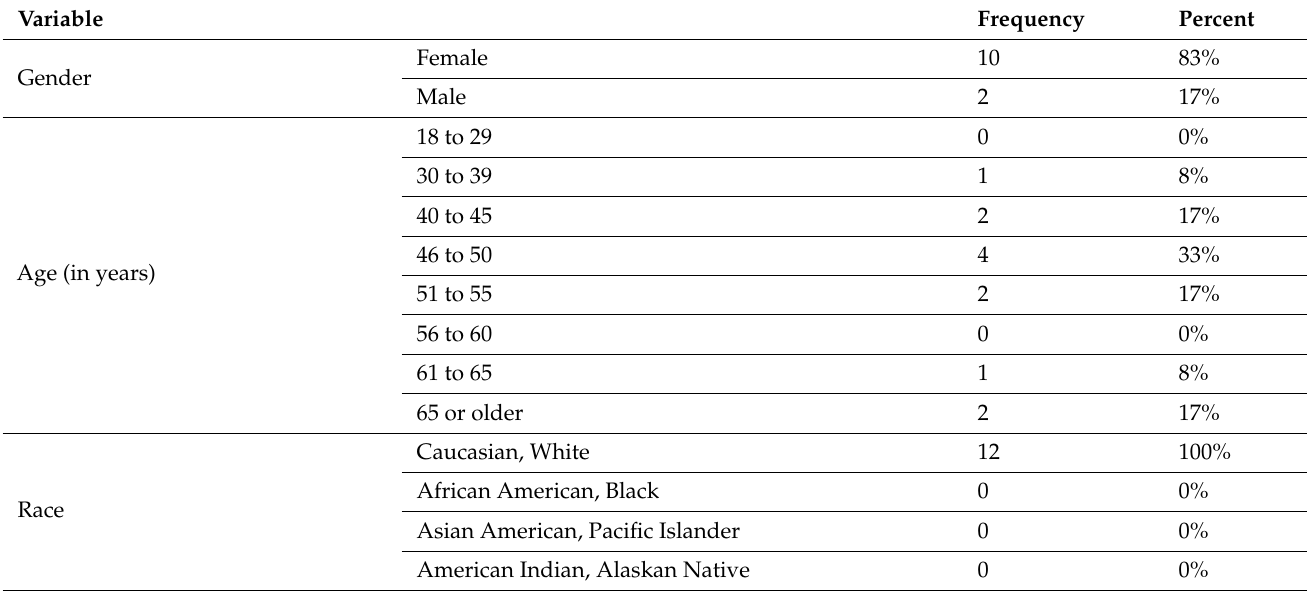
Table 1. Participant Demographics and Professional Characteristics (n = 12).